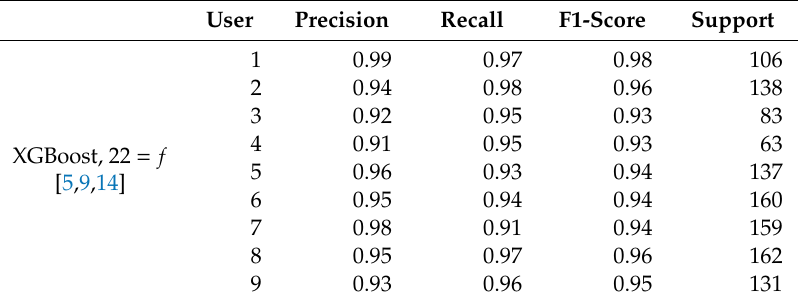
Table 12. Validation—selected environmental and biometric data for user identification.